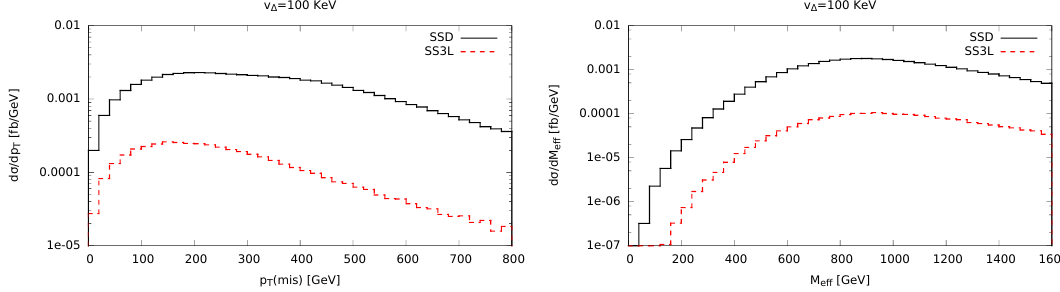
Figure 19 . Missing transverse momentum, p T , (left panel) and e(cid:11)ective mass, M e(cid:11) (right panel) distributions for SSD and SS3L events after the acceptance